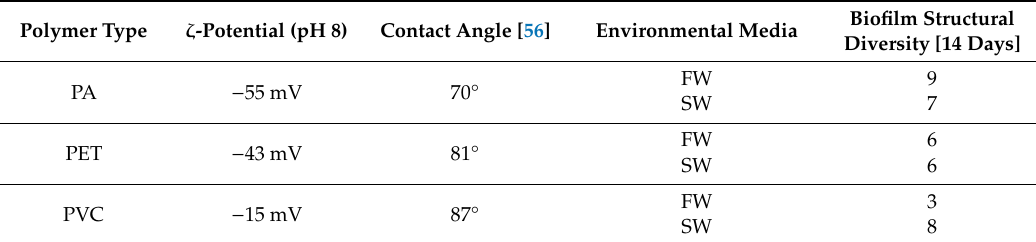
Table 3. ζ -potential at pH 8, contact angles, and the overall number of structural diversities on the surfaces of the three polymers after the incubation in freshwater (FW) and seawater (SW) within two weeks. Polymer